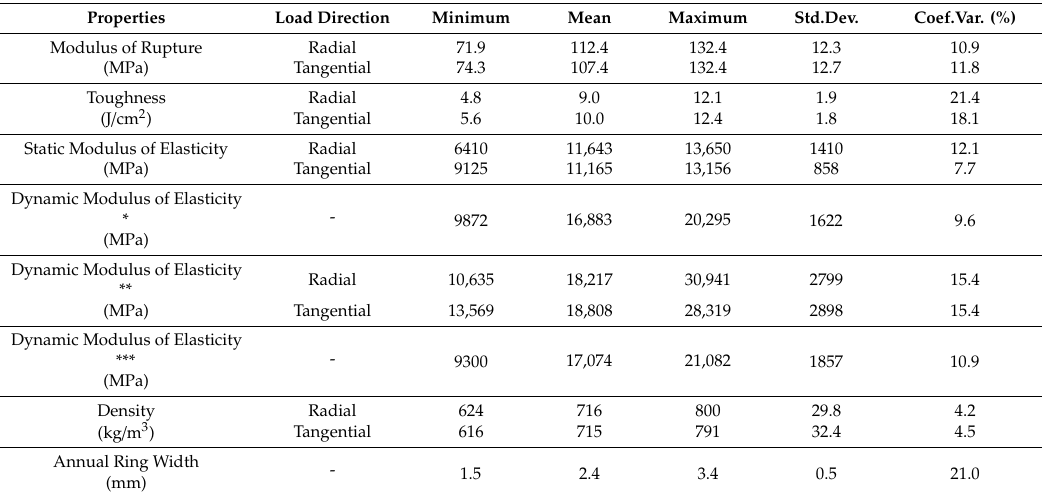
Table 4. Basic Statistical Analyses of the Properties for Birch Wood.